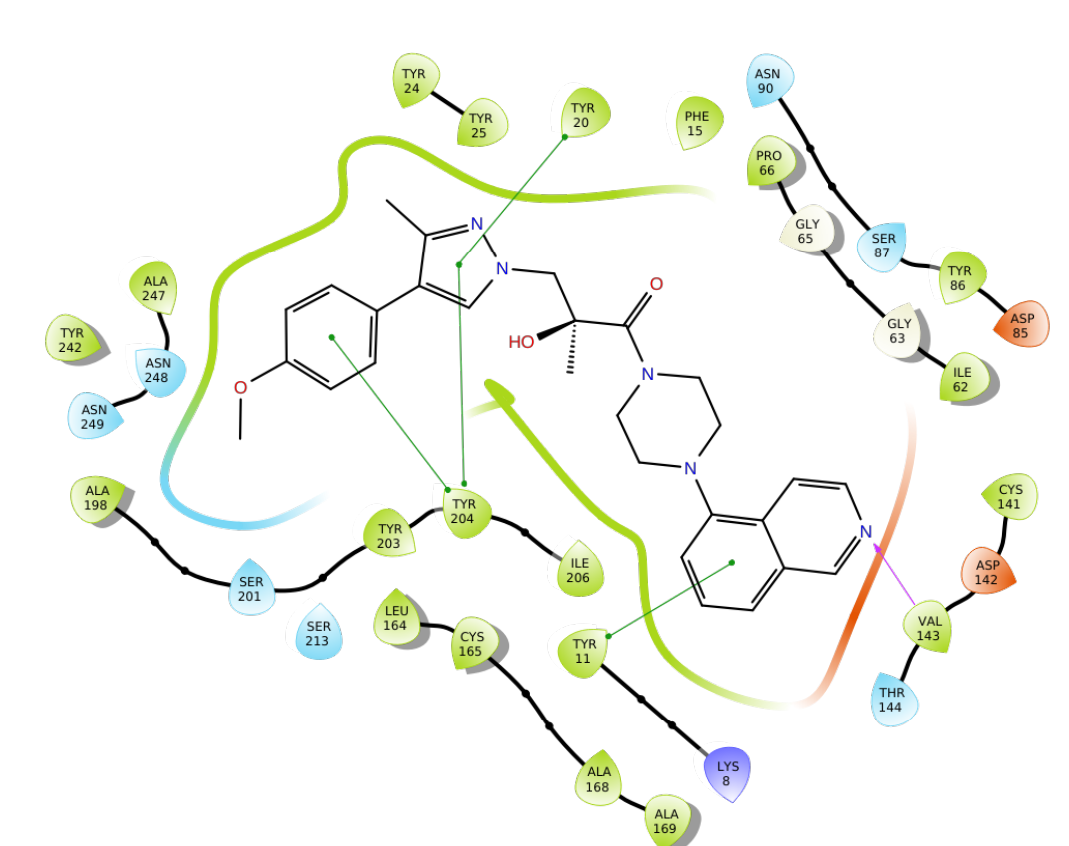
Figure 9. Ligand interaction diagram showing aromatic interactions of compound 12. This figure was made using the Ligand Interaction Diagram module of Schrodinger/Maestro v2016-2.